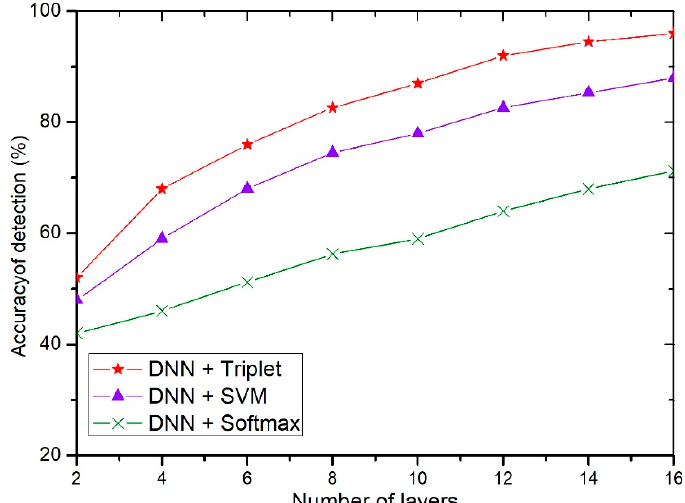
Figure 6. Performance changes with the increase of neural network layers. DNN = deep neural network; SVM = support vector machine.